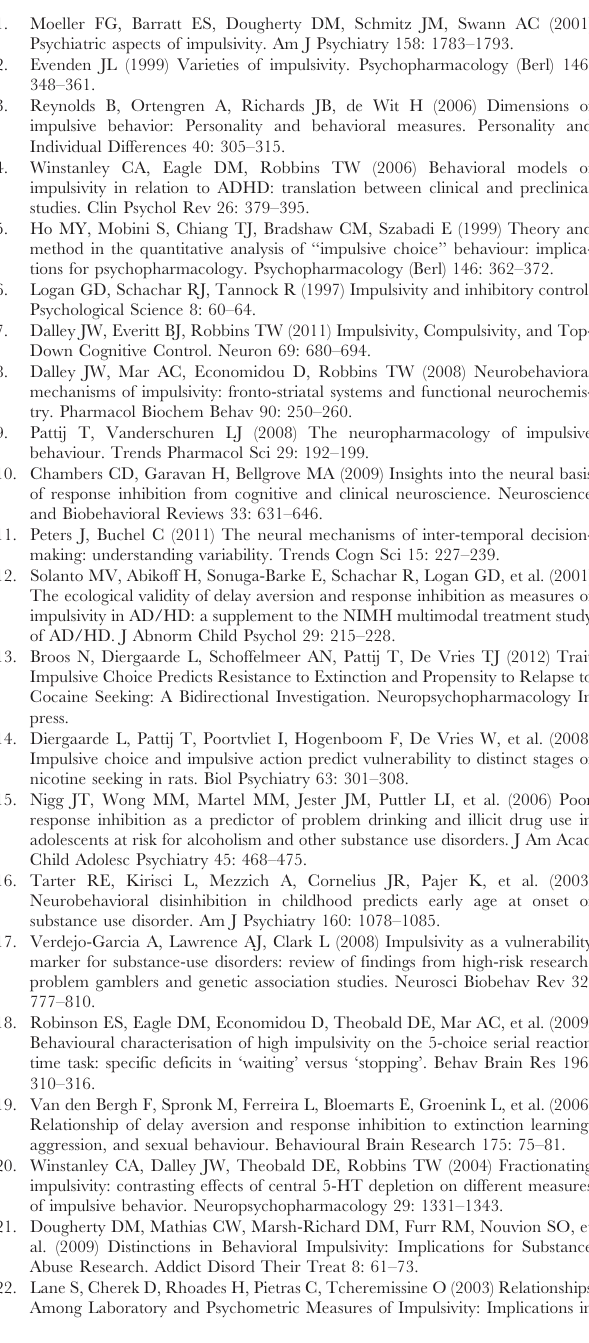
decreased accuracy. ATO decreased the number of premature responses. The other dependent measures remained unchanged. Table S3 The correlations between the various impul- sivity measures in humans (N =100). The subscales of the BIS-11 correlated significantly with each other. In addition, there was a significant correlation between the IMT Ratio and DMT Ratio and between the DMT Ratio and Stop SSRT. Table S4 The demographic characteristics and the impulsivity scores in humans (N= 100). There were no